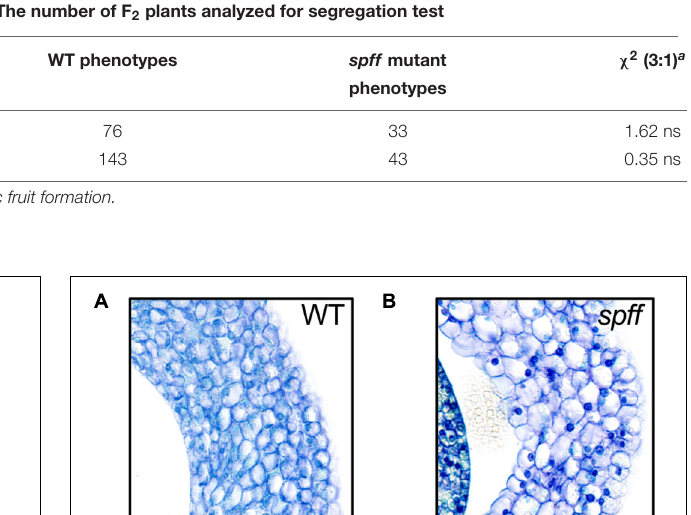
TABLE 1 | Segregation test of spff mutant traits at F 2 progeny of a self-pollinated F 1 plant. Parental genotypes